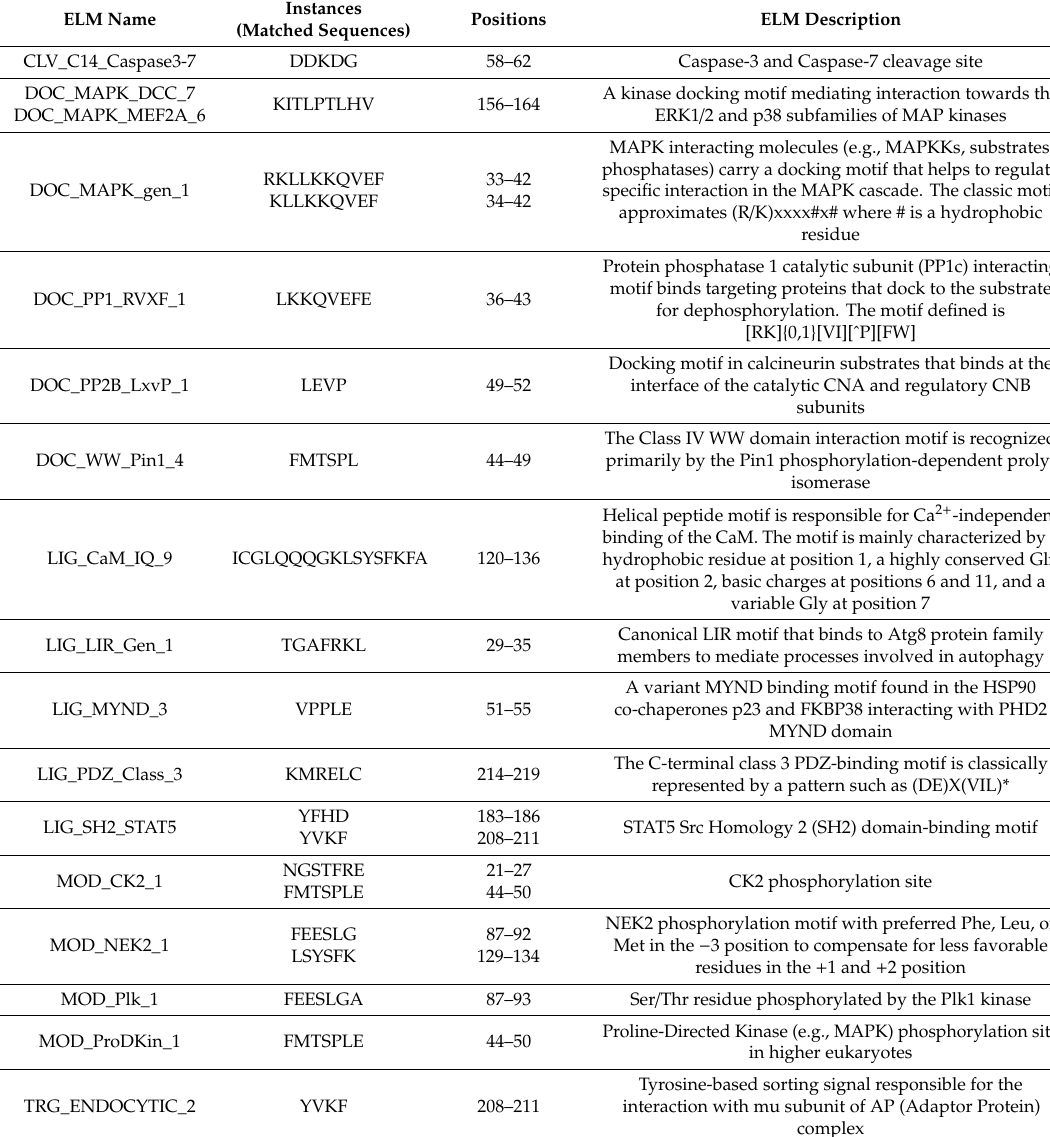
Table 1. Results of Eukaryotic Linear Motif (ELM) motif search within the primary structure of